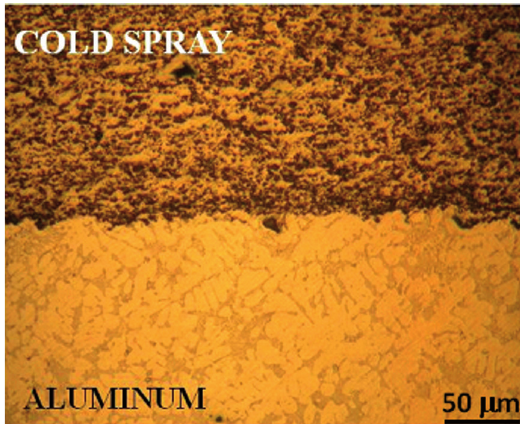
Figure 6: Cross section macrograph of the cold spray repair.